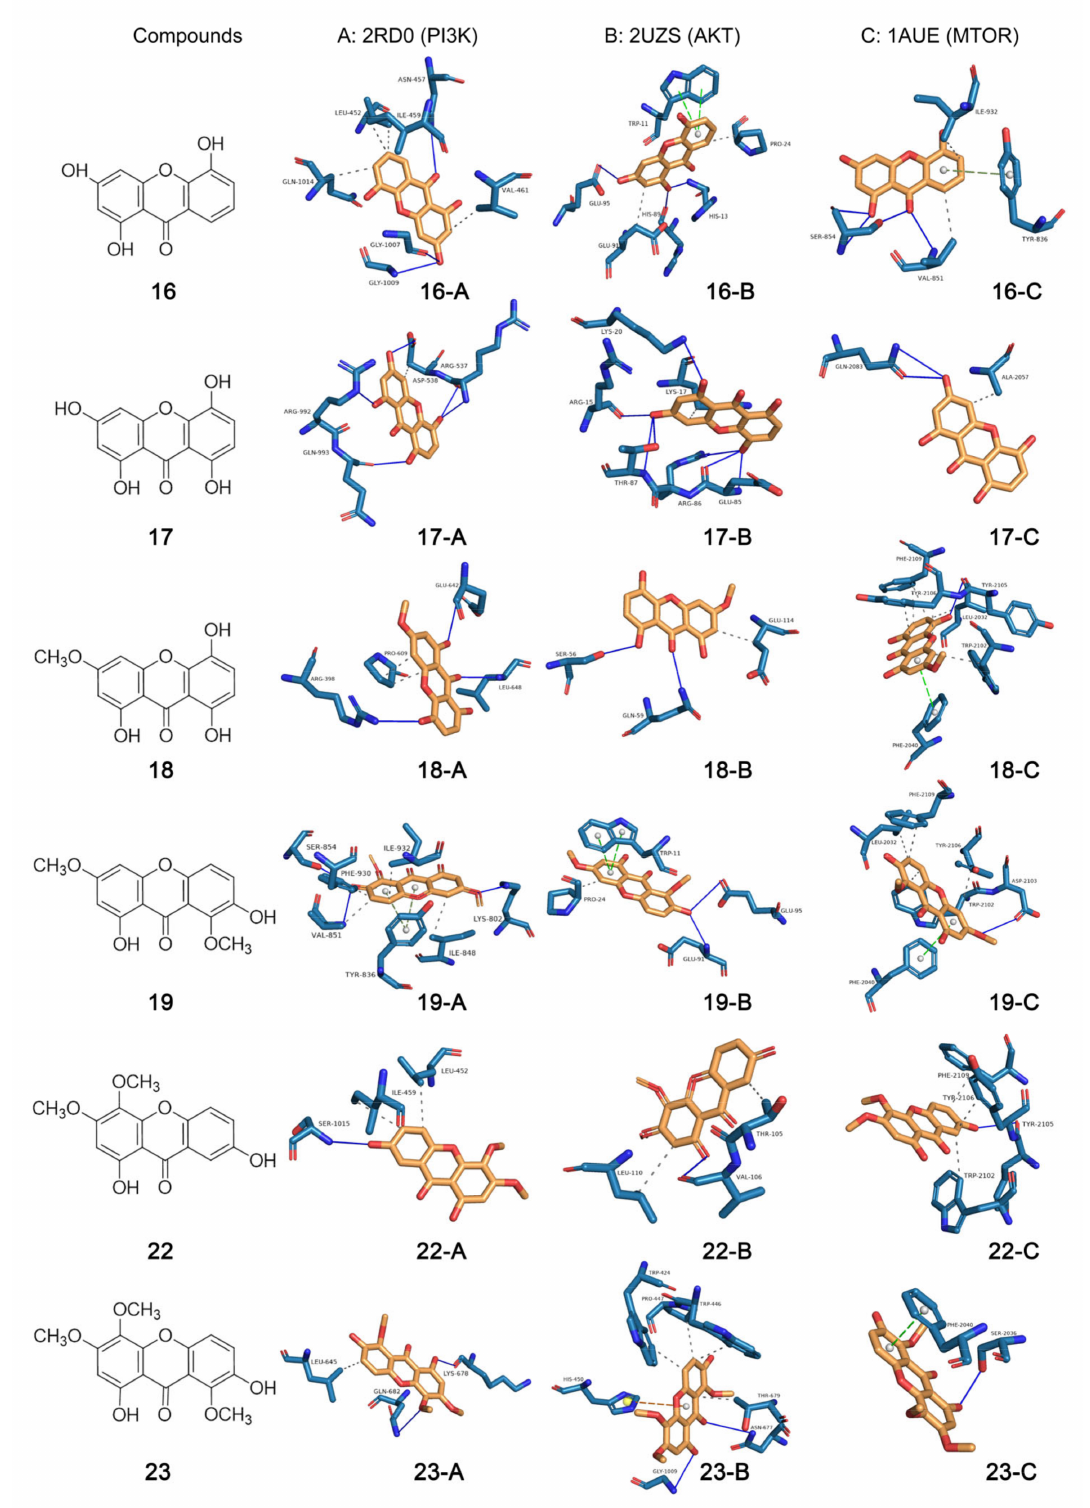
Figure 6. Molecular docking diagram of proteins. ( A ) 2RD0-PIK3CA, ( B ) 2UZS-Akt1, ( C ) 1AUE- mTOR and ligands (xanthones 16 – 19 , 22 and 23